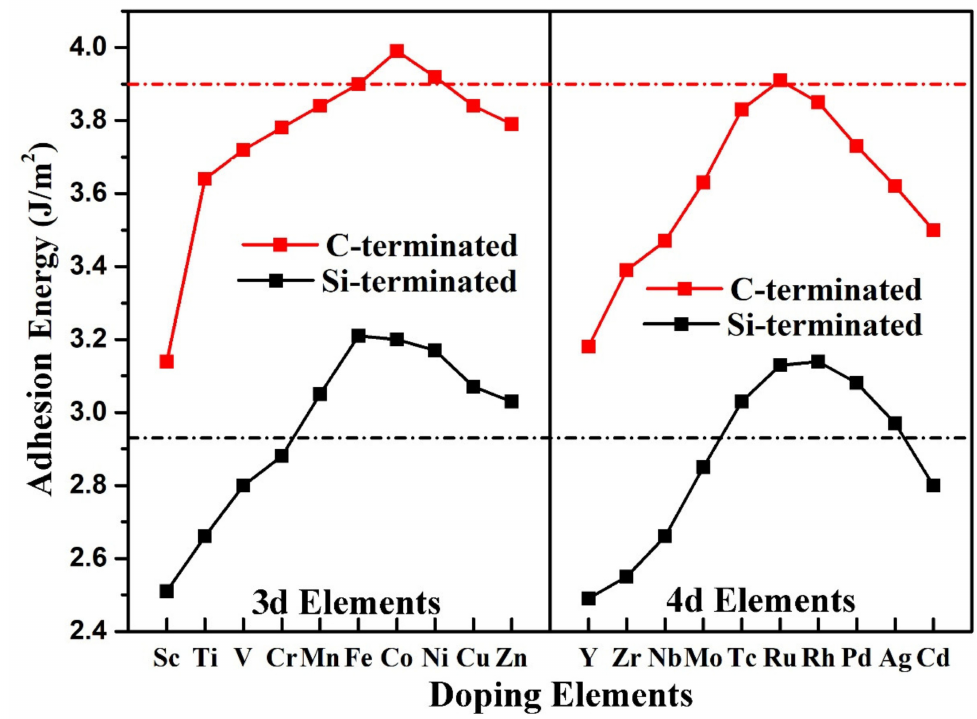
Figure 3. Adhesion energies of the Al-X(111)/SiC(0001) interface with different doping elements. The red and black dashed lines represent adhesion energies of pristine C-terminated and Si-terminated Al(111)/6H-SiC(0001) interfaces,